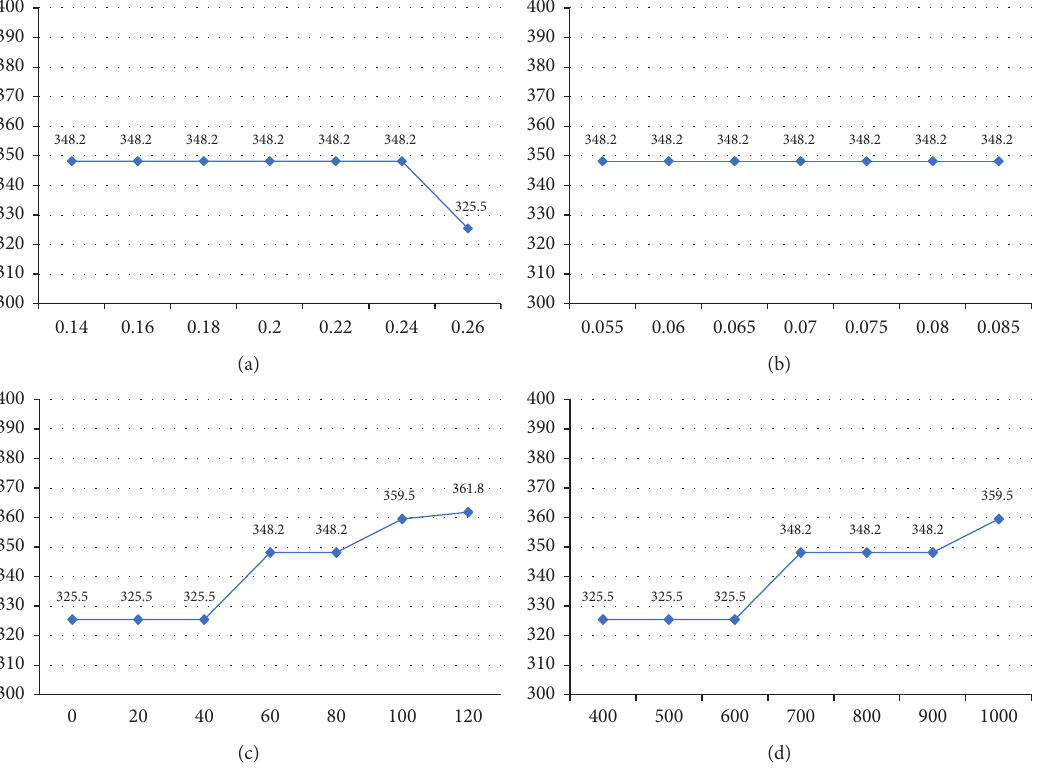
Figure 9: Influence of parameter values on price. (a) Transportation costs (Yuan/ton-km). (b) Pretreatment rate of kitchen waste. (c) Residual value of kitchen waste (Yuan/ton). (d) Penalty fee